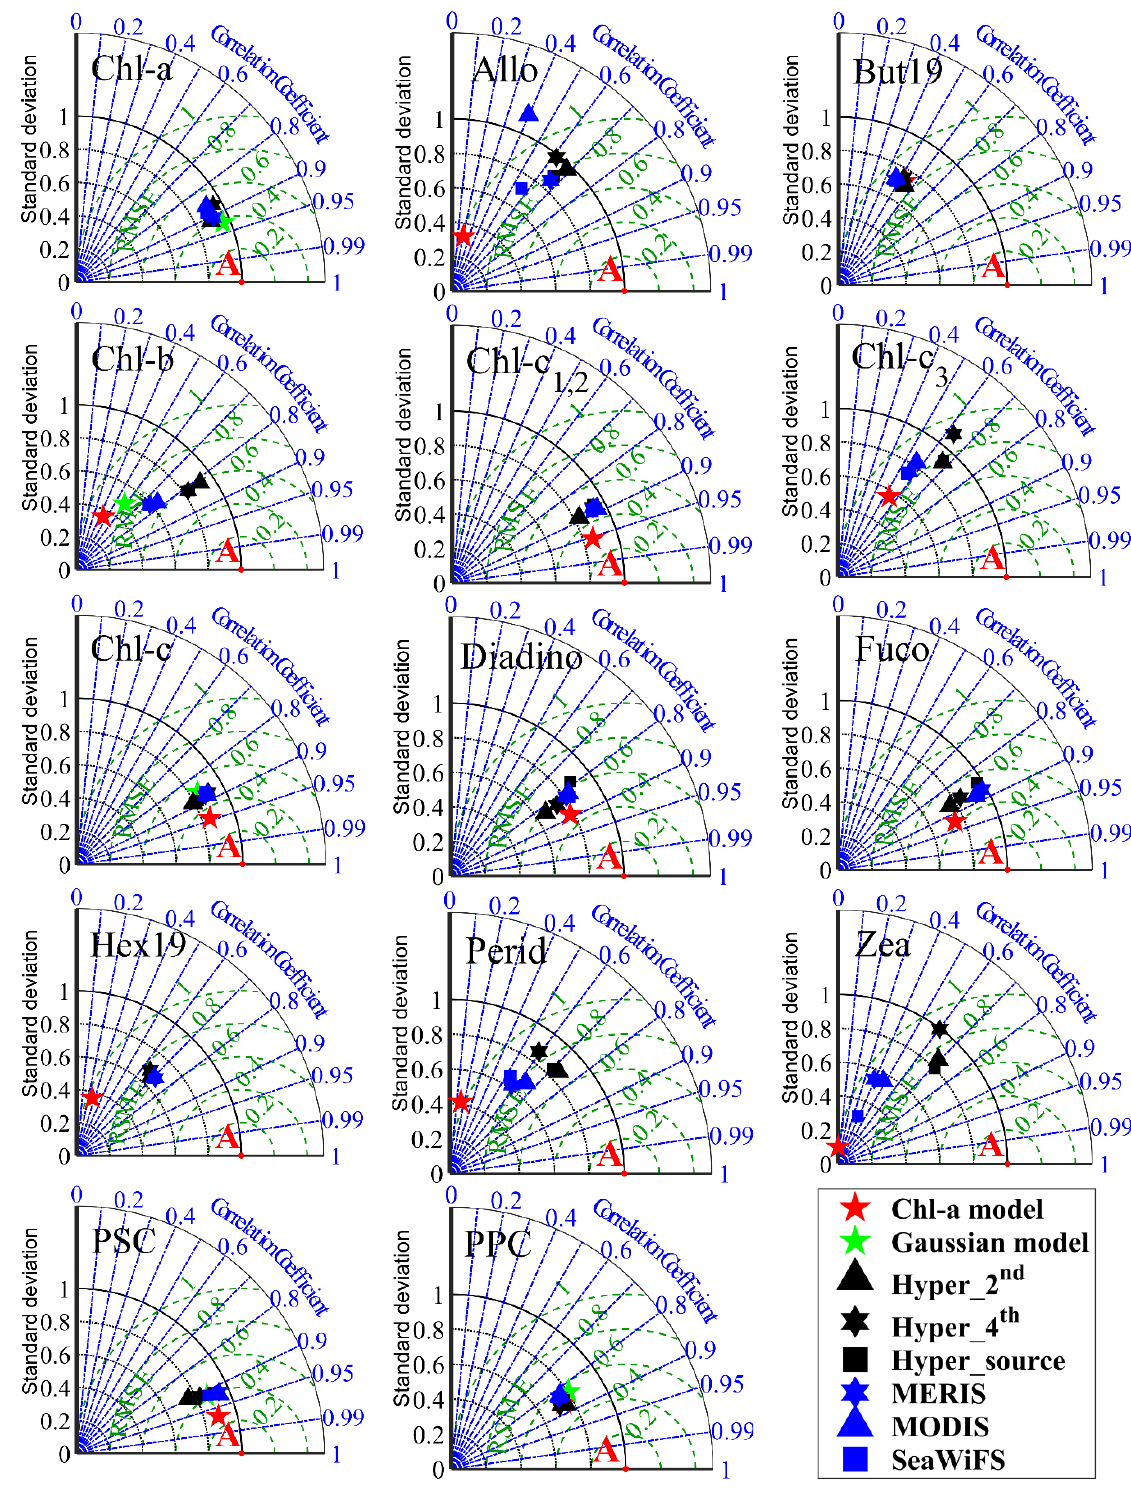
Figure 9. Taylor diagrams illustrating the relative model performances of the Chl-a model, Gaussian model, and PLS model (based on 𝑎 (cid:2886) (λ) , 𝑎 (cid:2886)(cid:4593)(cid:4593) (𝜆) , 𝑎 (cid:2886)(cid:2872)(cid:2930)(cid:2918) (𝜆) , Multi_SeaWiFS, Multi_MODIS, and Multi_MERIS). The correlation coefficient, normalized standard deviation, and normalized RMSE are presented in the Taylor diagrams. The red dot labeled “A” represents perfect model performance. A model performs better if the retrievals are closer to the red dot A. All parameters were calculated based on log-transformed pigment concentration.